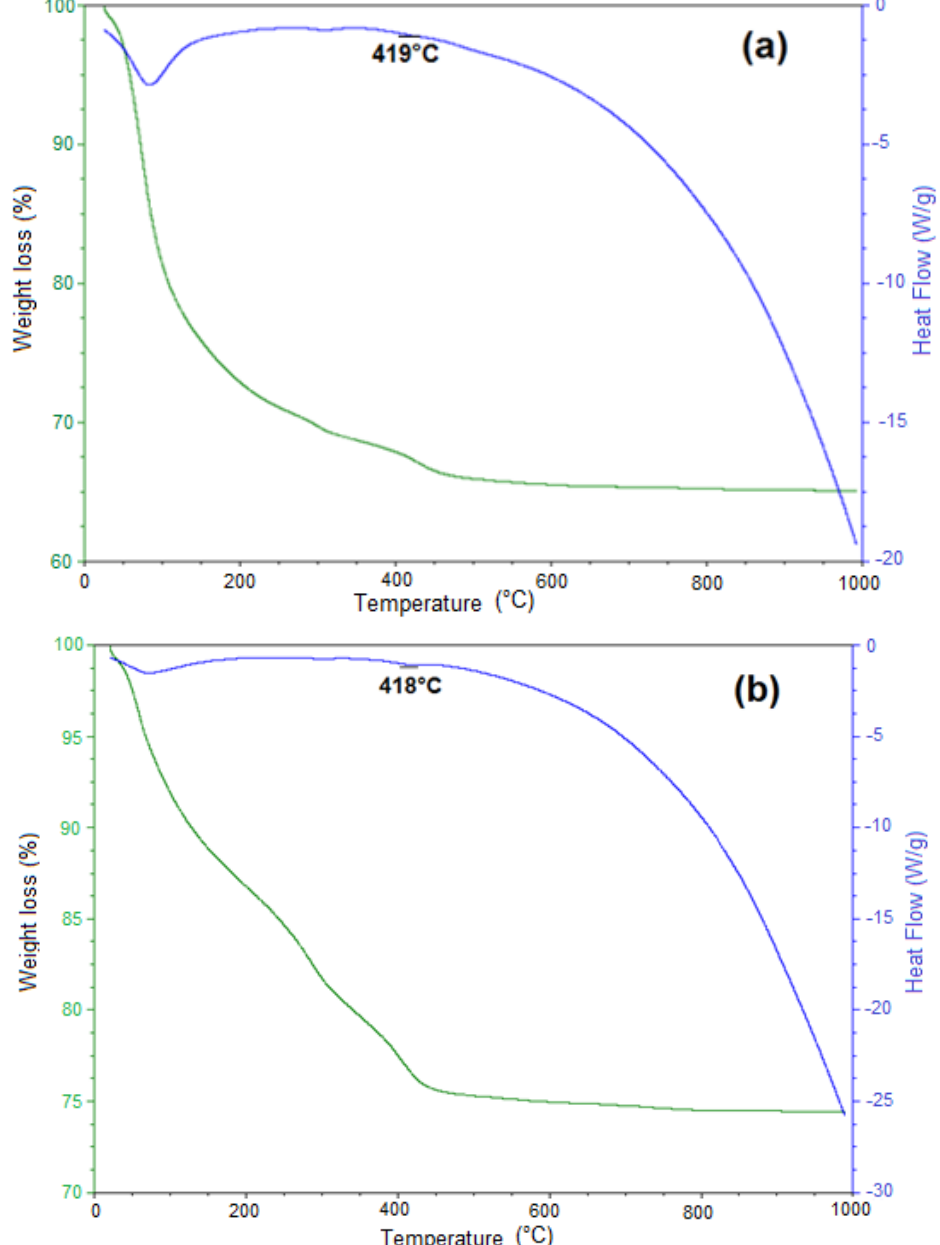
Figure 6. Thermogravimetric (TG)-heat flow plot of thermal decomposition of the product formed at 30 bar CO 2 pressure, 400 rpm, and 20 h ( a ), and at 50 bar, 100 ◦ C, 4 h ( b ), heating rate 10 ◦ C / min in an 30 bar CO 2 pressure, 400 rpm, and 20 h ( a ), and at 50 bar, 100 °C, 4 h ( b ), heating rate 10 °C/min in an argon argon atmosphere.